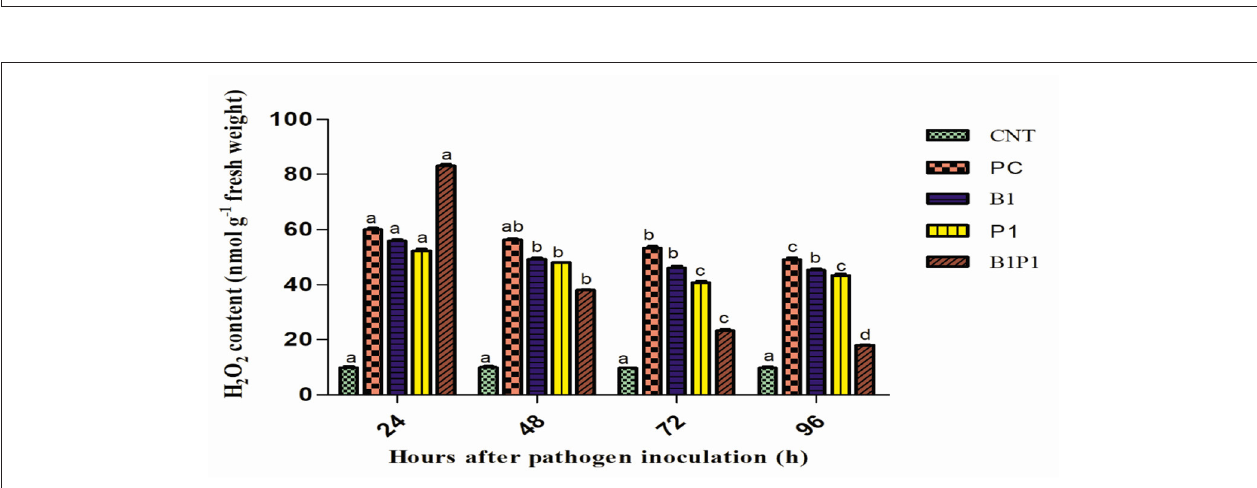
FIGURE 7 | The H 2 O 2 content in tomato leaves treated with different treatments from 24 to 96h after pathogen inoculation. Data are shown as the mean ± SE ( n = 3). Tukey’s B post-hoc test at 5% confidence level ( p < 0.05) was used to test the significance of the data. These alphabets denoted the different significant level.